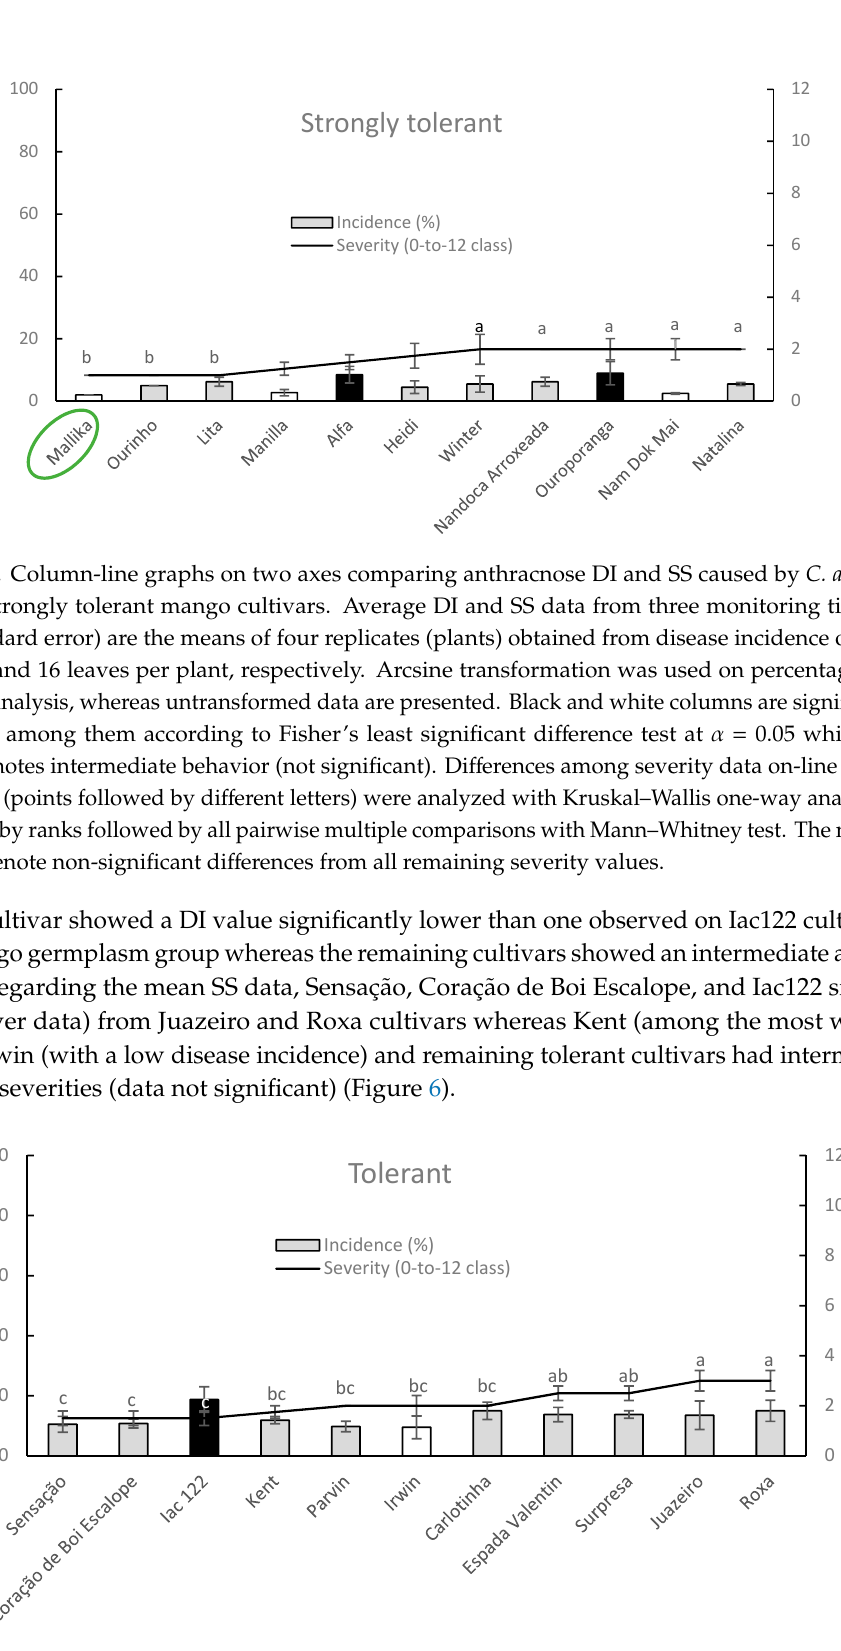
Figure 6. Column-line graphs on two axes comparing anthracnose DI and SS caused by C. asianum within tolerant mango cultivars. Data ( ± SE values) were collected and analyzed as above mentioned for the previous figure. Grey color of columns clearly shows the lack of significant di ff erences according to both parametric and nonparametric